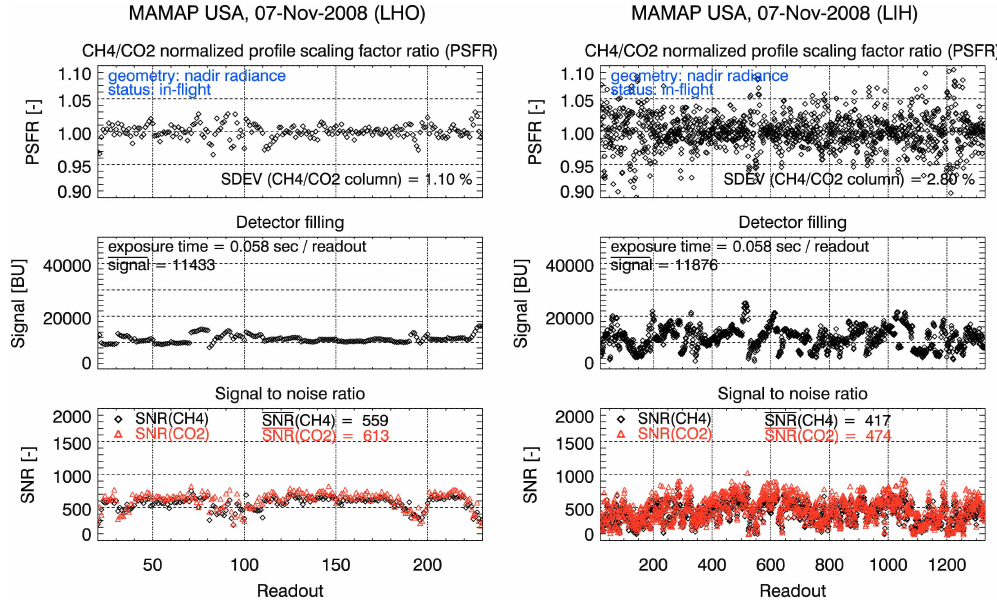
Fig. 10. As Fig. 8 but for in-flight nadir measurements over land; left: scene with homogeneous reflectance distribution (target LHO); right: scenes with inhomogeneous reflectance distribution (target